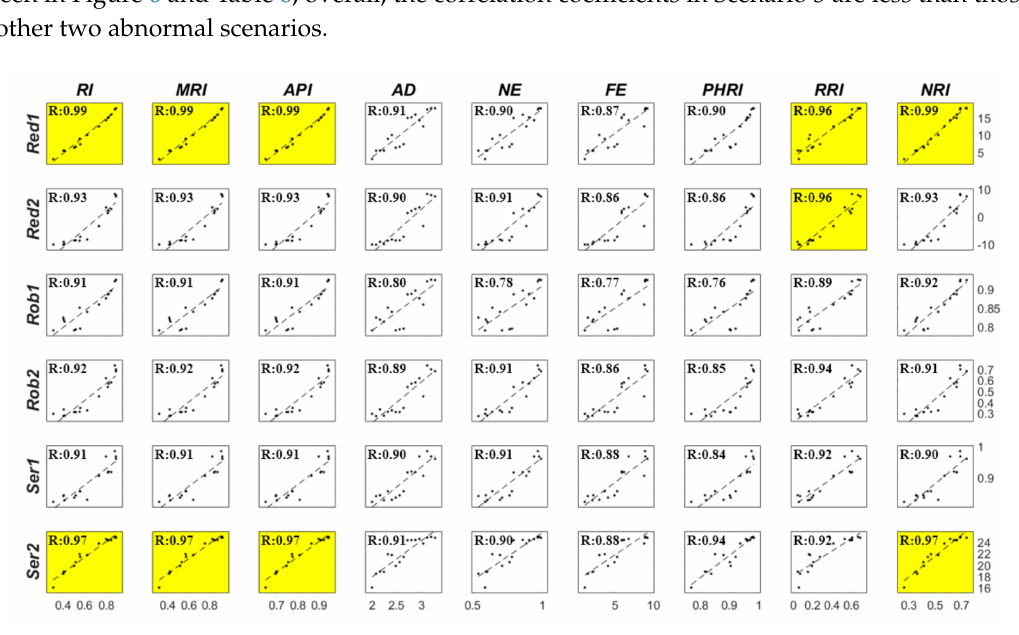
Figure 6. Scatter plots of Scenario 3 ( x -axis—Reliability index; y -axis—Hydraulic measure). The plots highlighted in yellow show high correlation coe ffi cient of 0.95 or higher. Table 6. Correlation coe ffi cients for Scenario